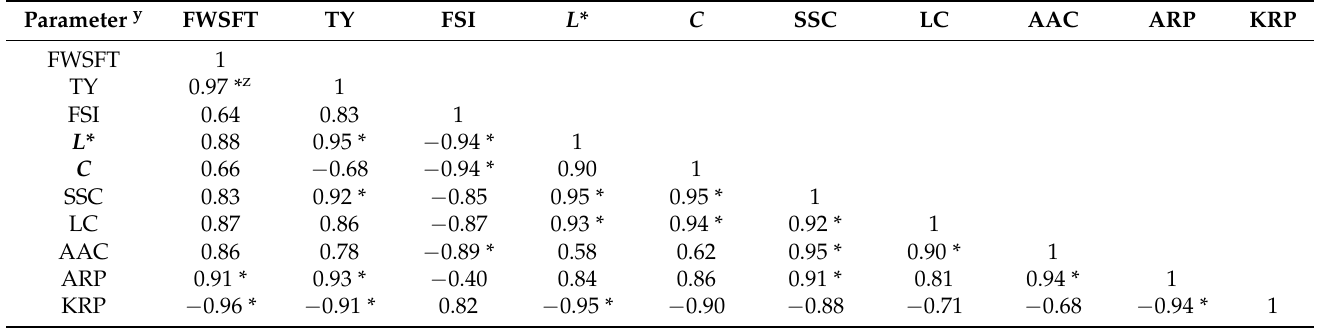
Table 5. Correlation analysis of selected fruit yield, appearance characteristics, flavor quality, nu- trients, and the aromatic substance of cherry tomatoes under different abaxial leafy supplemental lighting treatments.